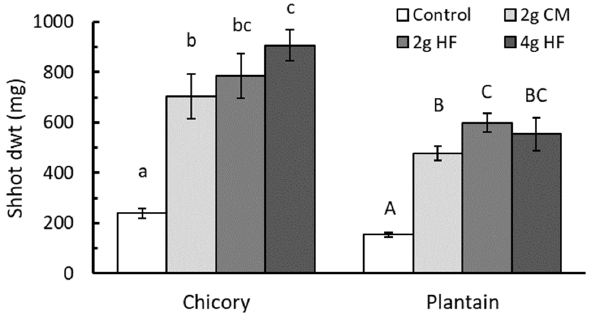
Figure 2. The effect of adding HexaFrass™ (HF; 2 g or 4 g per pot) and a standard organic fertilizer (chicken manure, CM; 2 g per pot) on the shoot growth of chicory and plantain grown under glasshouse conditions (mean ± SE). Only data for plants that survived until harvest are included. Letter codes separate treatments for each plant using LSDs at p < 0.005.